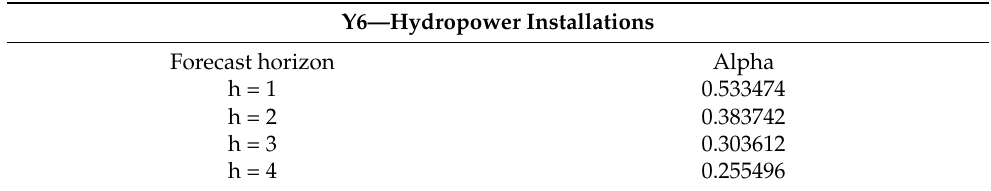
Table 8. Parameters of the exponential smoothing model for the variable Y 6